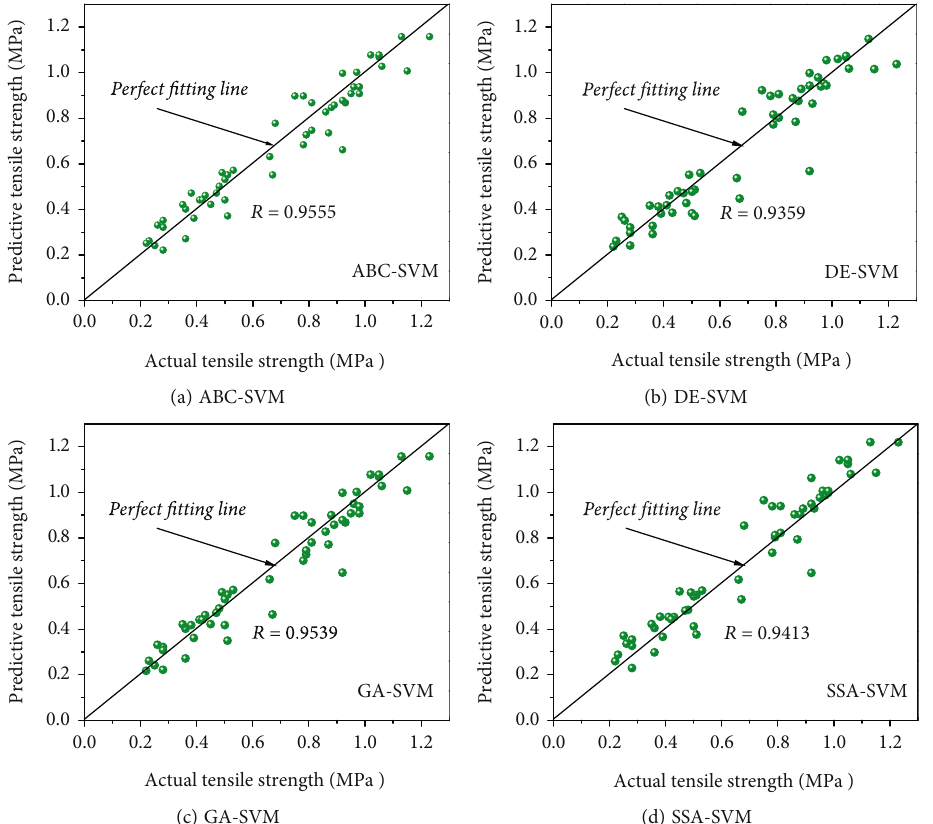
Figure 6: The prediction e ff ects of di ff erent prediction model for testing